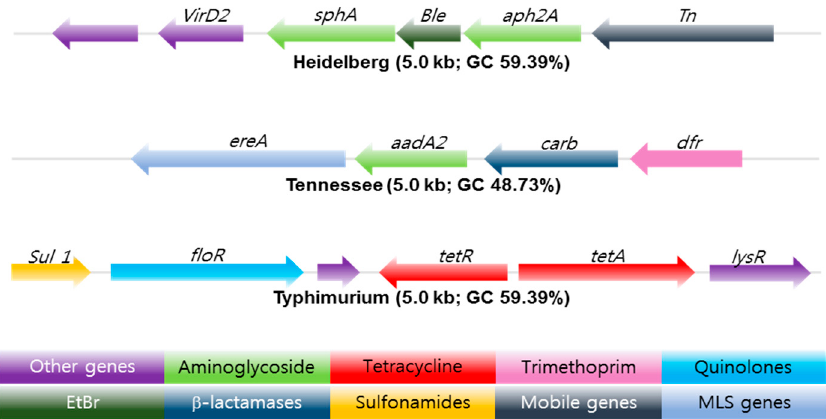
Figure 3. Antibiotic resistance gene clusters of three common Salmonella serotypes found in swine isolates from 2004–2005. EtBr resistance gene (Dark Green) flanked by antibiotic resistance genes marked in light green. The arrow shows the orientation of the genes; genes are color-coded to define different classes of antibiotic resistance, mobile, and other gene categories. Copyright permission PLOS One [45].